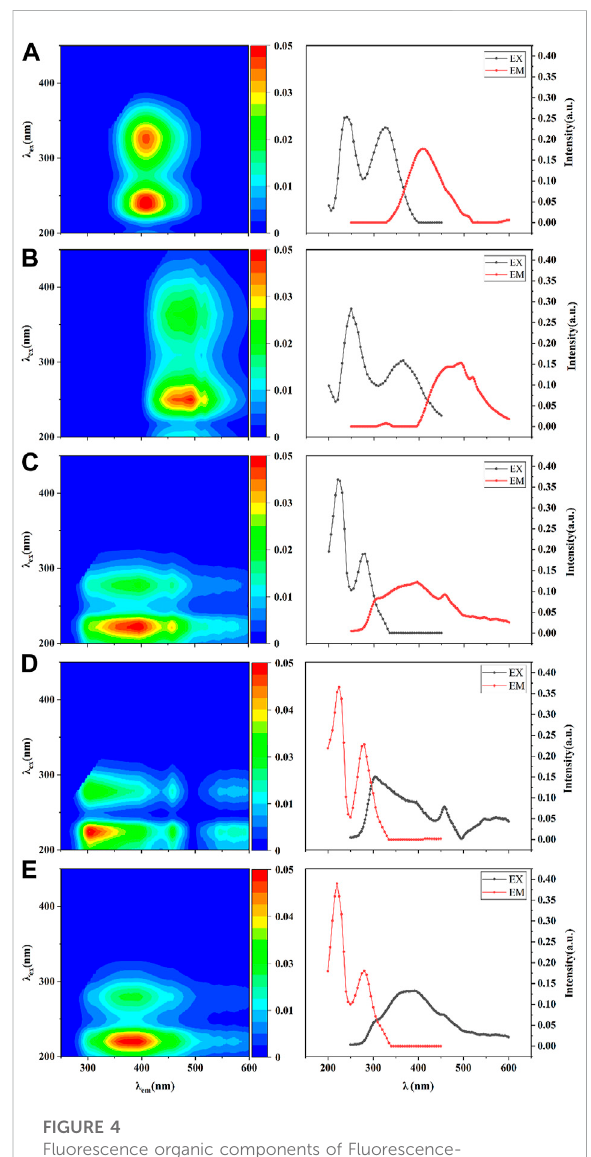
FIGURE 4 Fluorescence organic components of Fluorescence- PARAFAC; (A – E) denotesthe fi veorganiccomponents(C 1 -C 5 )and the variation with the emissions wavelength (EM) and excitation wavelength